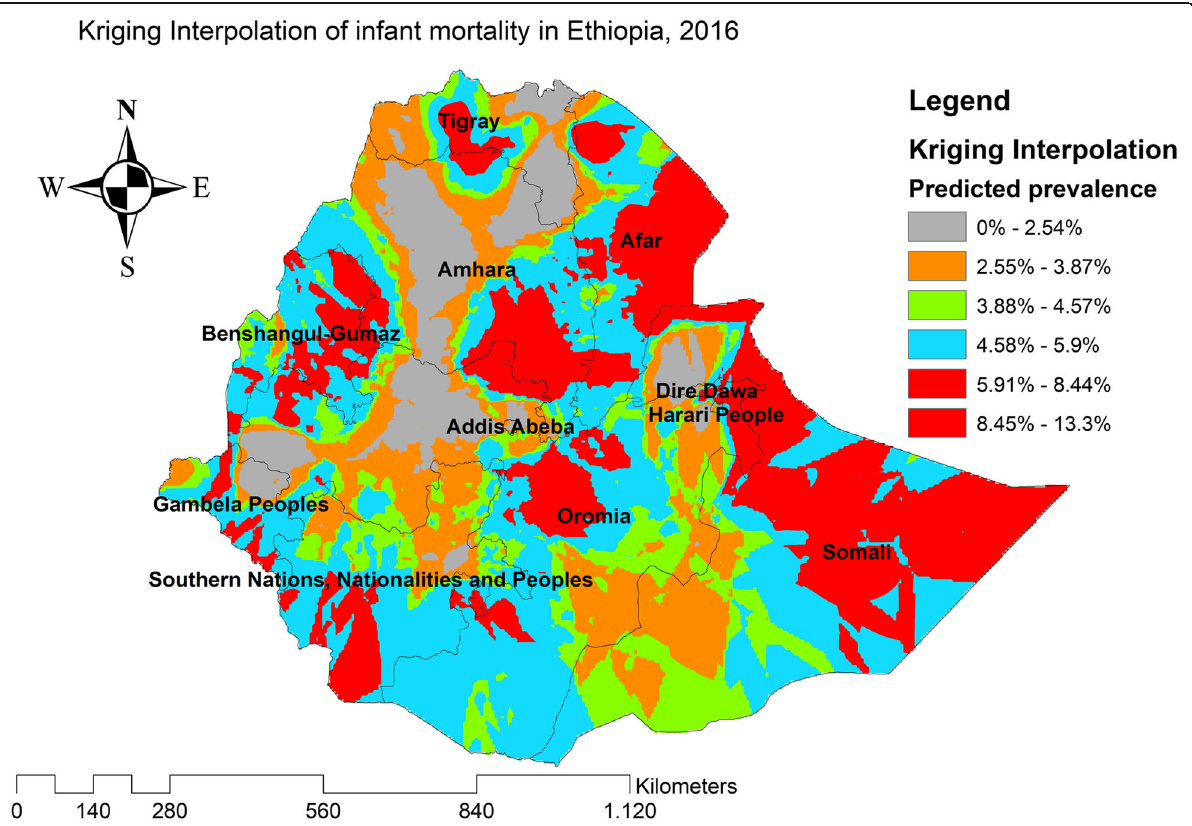
Fig. 9 The Kriging interpolation of infant mortality in Ethiopia